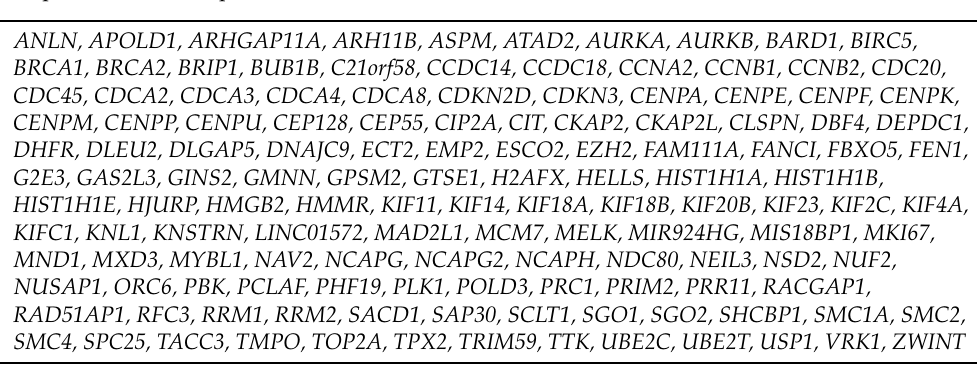
Table 5. Shared highly variable genes identified from CAFs/DAFs isolated from chronic pancreatitis and pancreatic cancer patients.